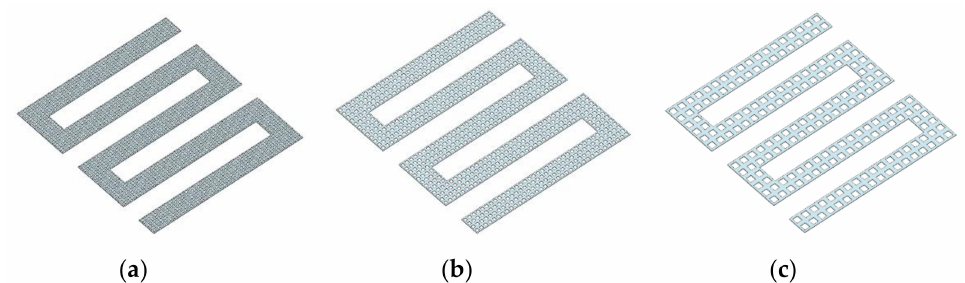
Figure 21. The three-dimensional structure of electrothermal film (( a ) pore size = 0.3 mm, ( b ) pore size = 0.6 mm, ( c ) pore size = 1.2 mm).